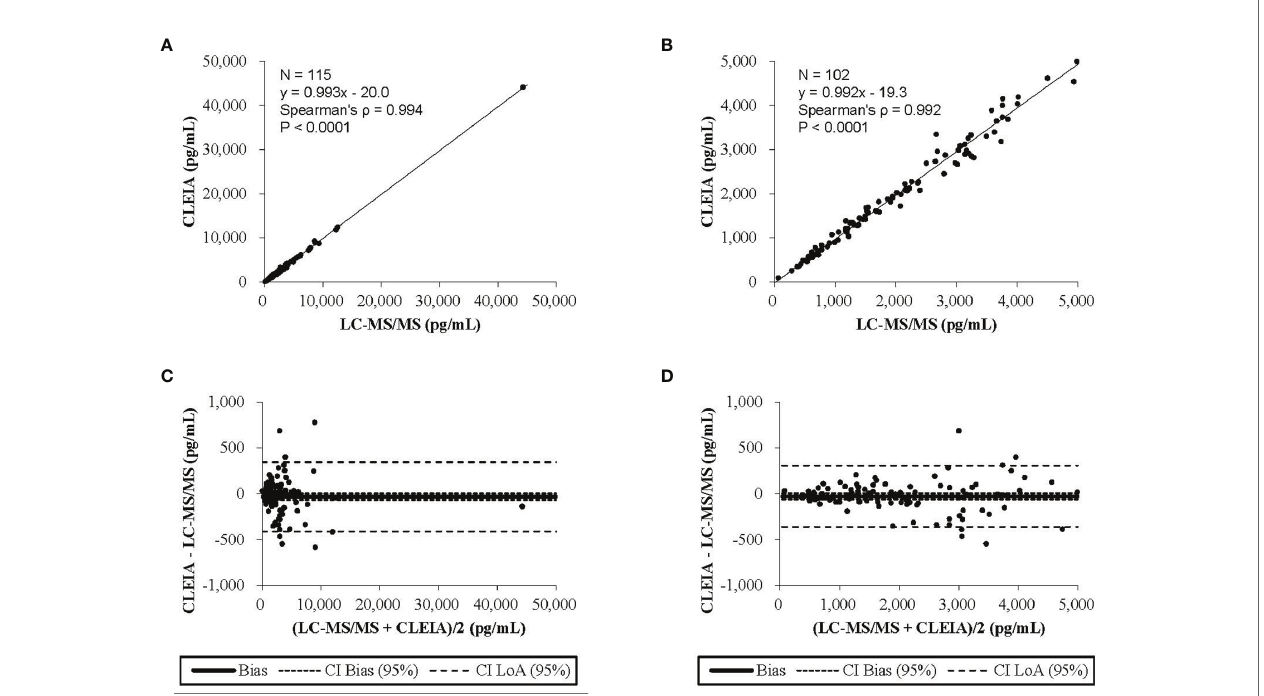
FIGURE 1 | The results of the Passing-Bablok regression analysis and the Bland-Altman analysis (A) The CLEIA versus the liquid chromatography-tandem mass spectrometry(LC-MS/MS). (B) The CLEIA versus the LC-MS/MS in a concentration range of up to 5000 pg/ml. (C) The CLEIA versus the LS-MS/MS. (D) The CLEIA versus the LS-MS/MS in a concentration range of up to 5000